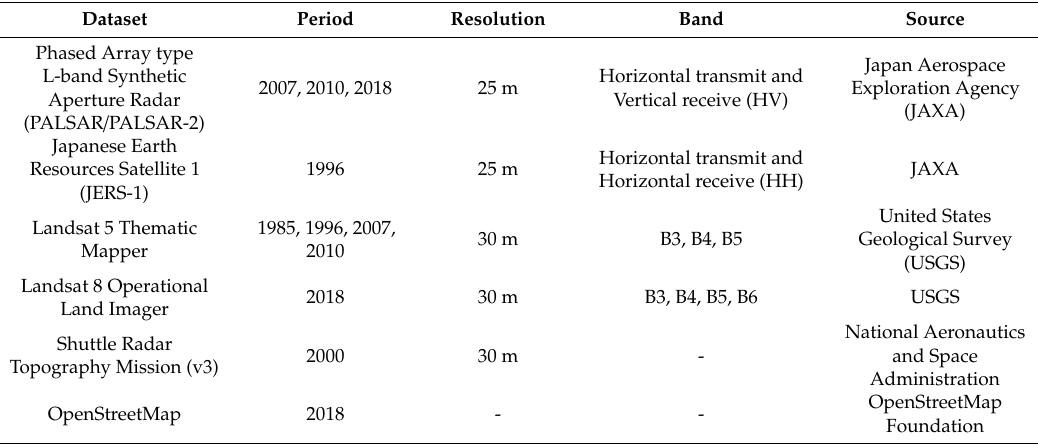
Table 1. Details of the datasets and sources used in this